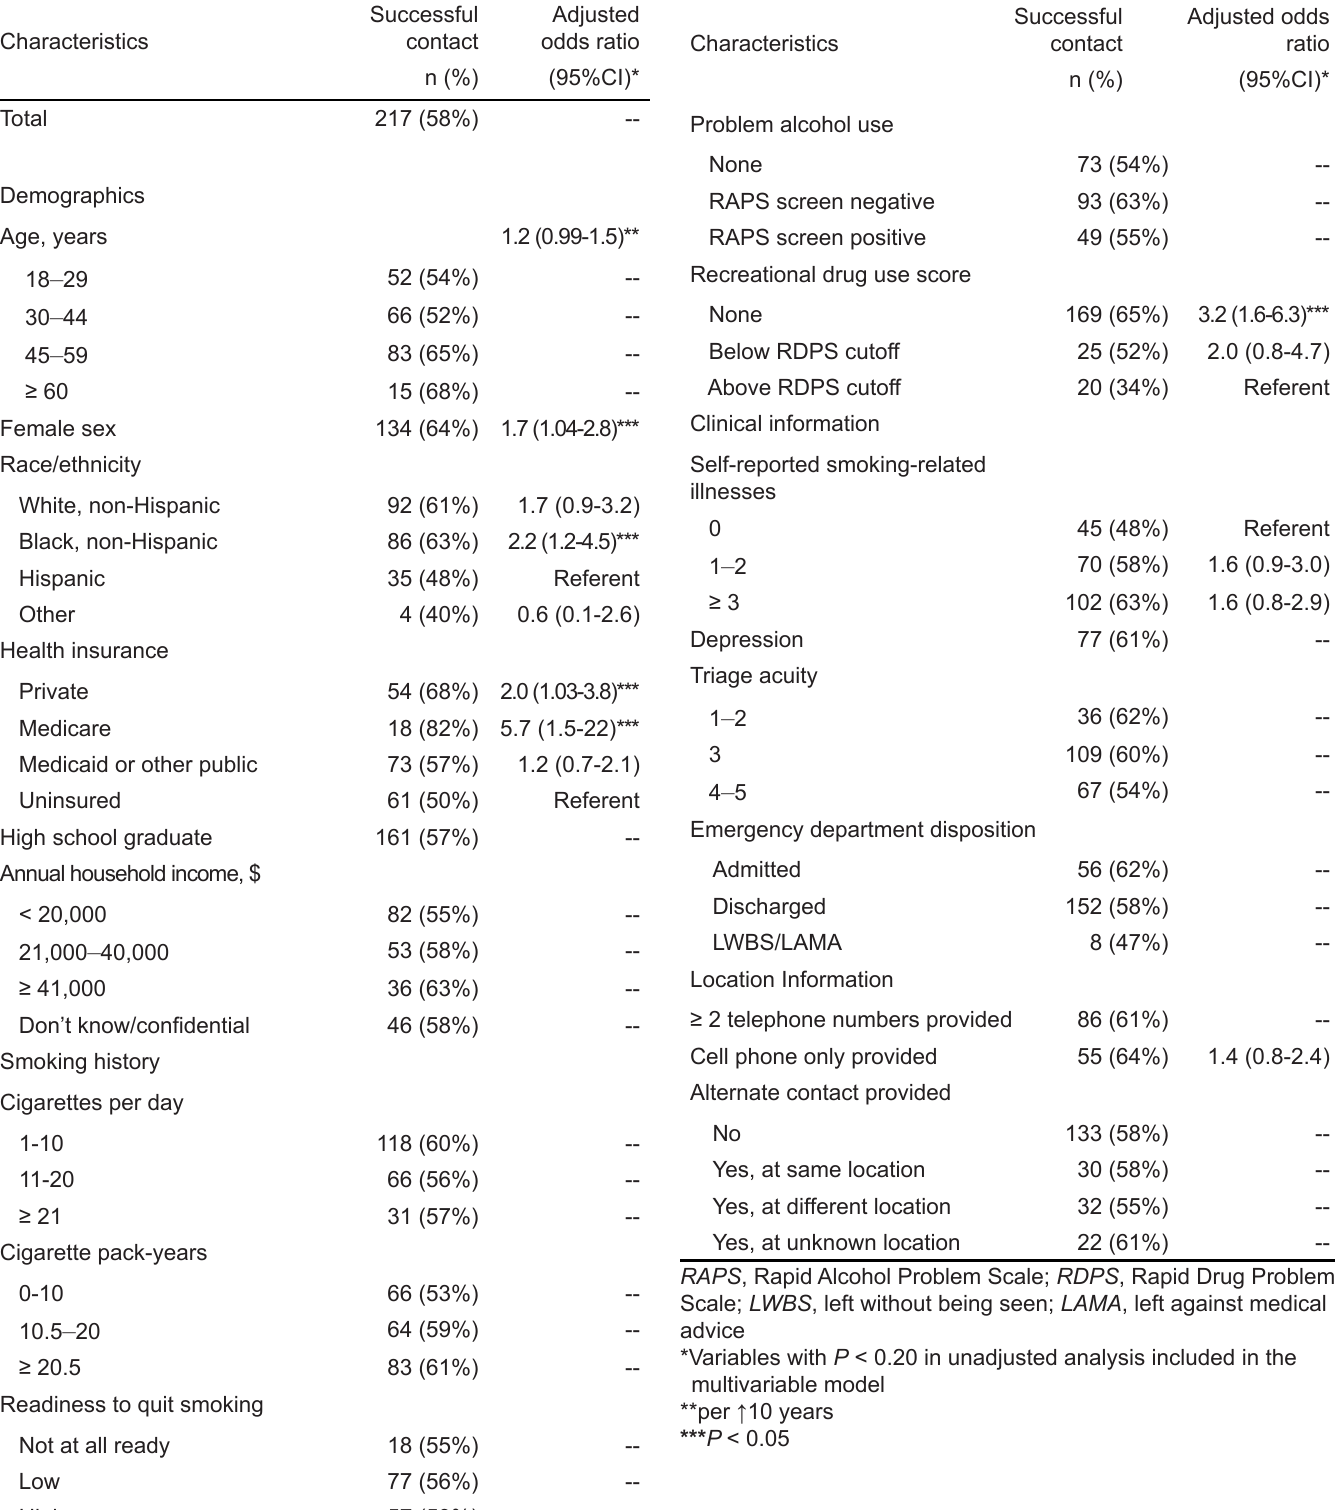
Table 2. Association between baseline participant characteristics and successful contact at 6 months.